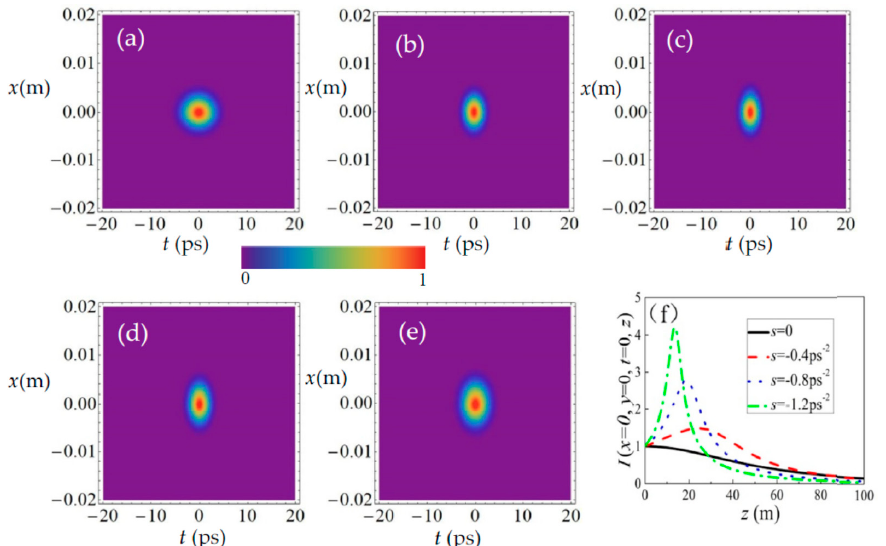
Figure 8. Density plots for the normalized spatiotemporal intensity I ( x , y , t , z ) (Equation (20)) of SCTLGSM pulsed beam in the x – t plane at some propagation distances ( a ) z = 0, ( b ) z =20 m, ( c ) z =30 m, ( d ) z =40 m, ( e ) z =50 m and for s = − 0.4ps − 2 , n = 0, m = 0. ( f ) Normalized intensity I ( x , y , t , z ) (Equation (22)) of SCTLGSM pulsed beam as a function of propagation distance z for different chirp coefficients s = 0, − 0.4ps − 2 , − 0.8ps − 2 , − 1.2ps − 2 .